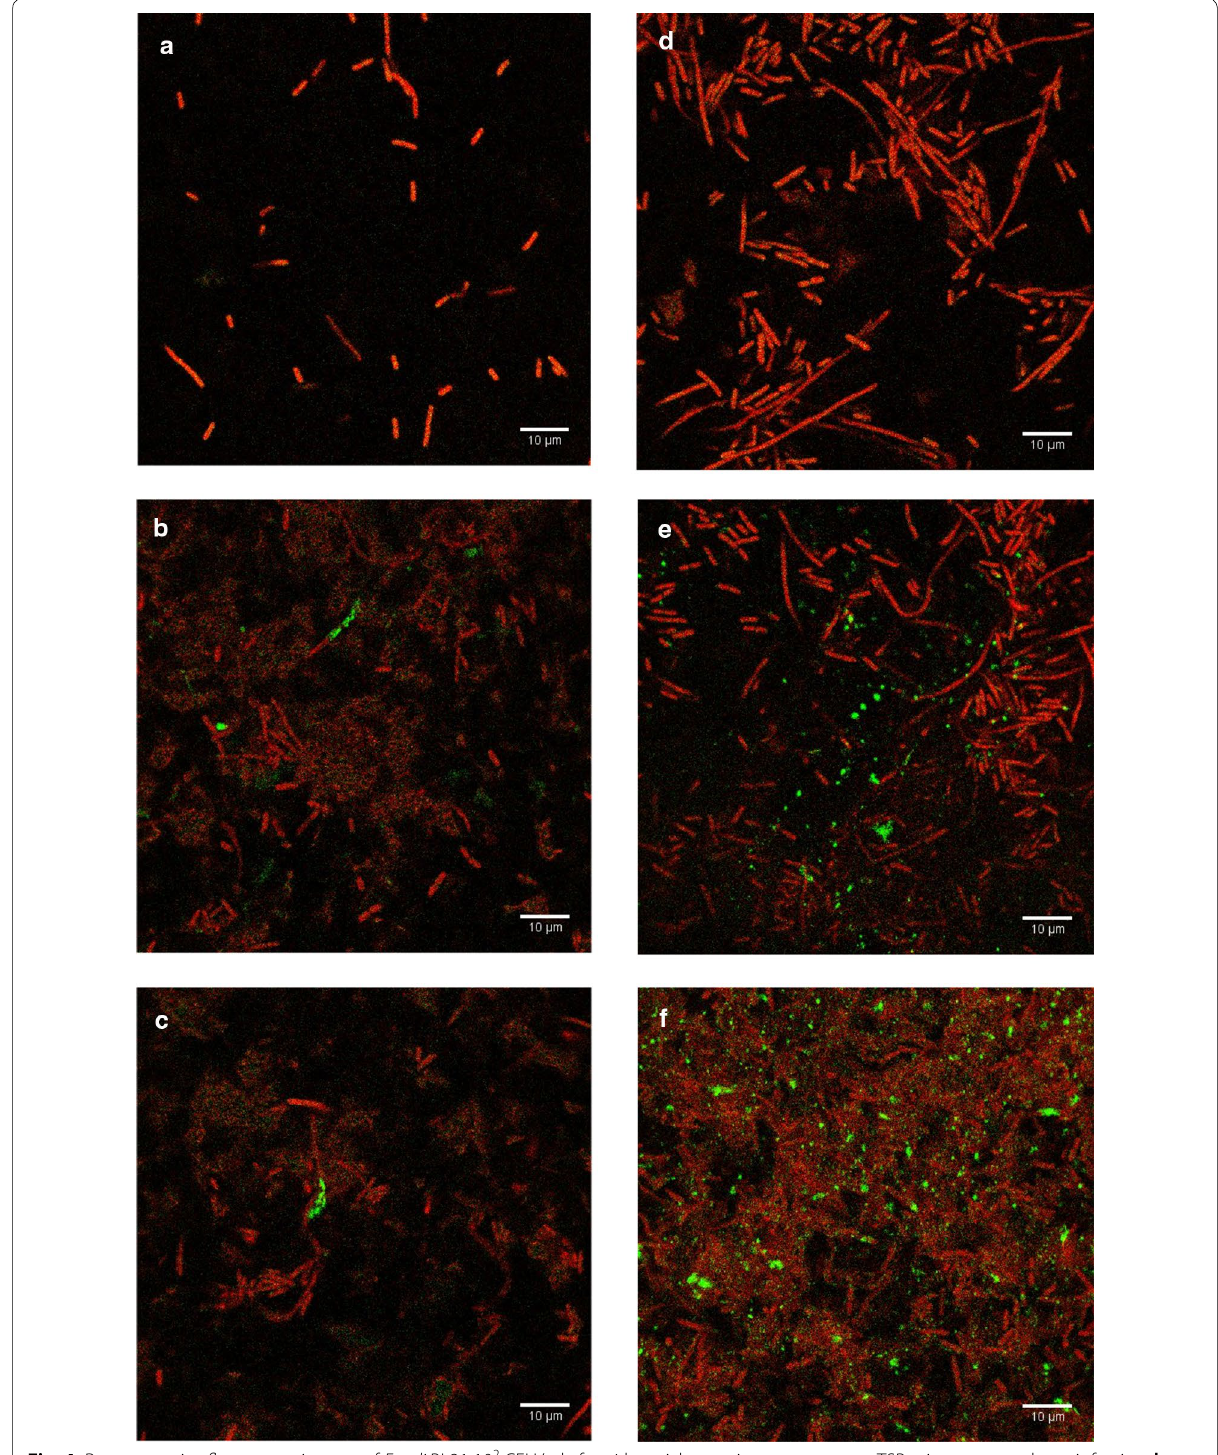
Fig. 4 Representative fluorescent images of E. coli BL21 10 2 CFU/ml after 4 h enrichment in coconut water-TSB mixture: a no phage infection, b after 15 min of T7-ALP infection, c after 30 min of T7-ALP infection. Fluorescent images of E. coli BL21 10 3 CFU/ml after 4 h enrichment in coconut water-TSB mixture: d no phage infection, e after 15 min of T7-ALP infection, f after 30 min of T7-ALP